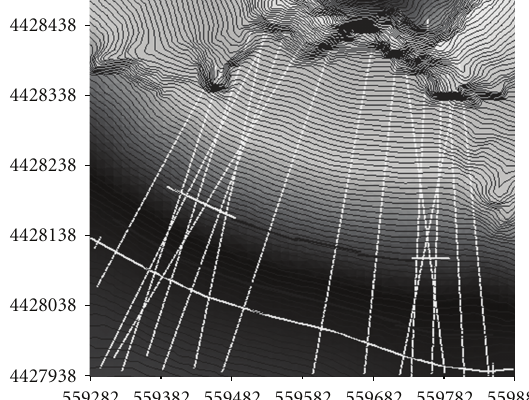
Figure 4: Location of the simulation profiles. Sections and SS18 road are indicated on the map. The area inside the rectangle represents the instable part of the slope.